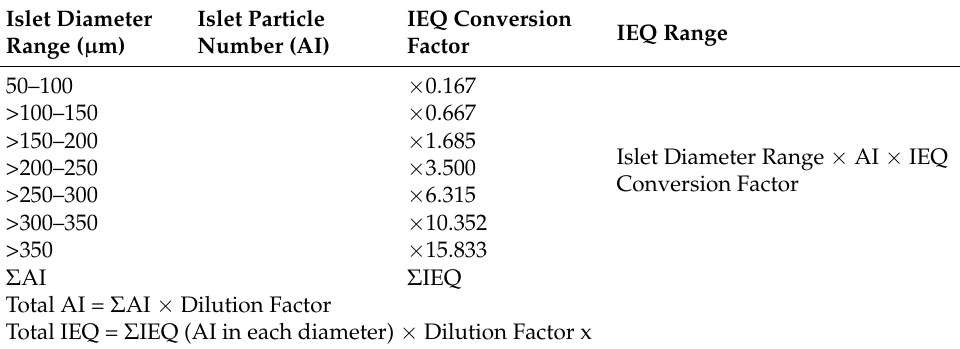
Table 1. Equations for evaluation of Total IEQ and Total